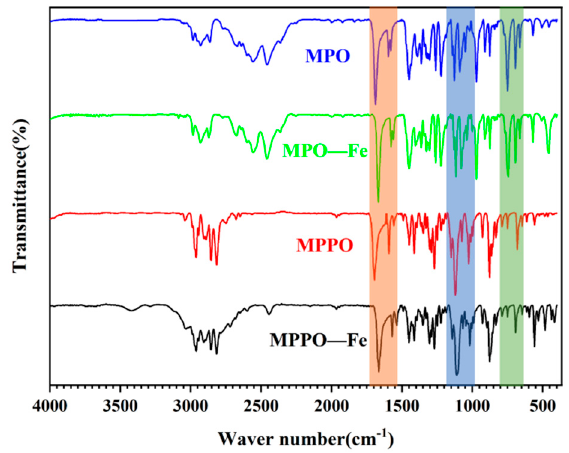
Figure 9. FT-IR adsorption spectrum of free inhibitors (MPO and MPPO) and scrapped samples (MPO-Fe and MPPO-Fe). Table 6. FT-IR absorption frequencies for the free inhibitors and the adsorbed inhibitors on the N80 steel surface.